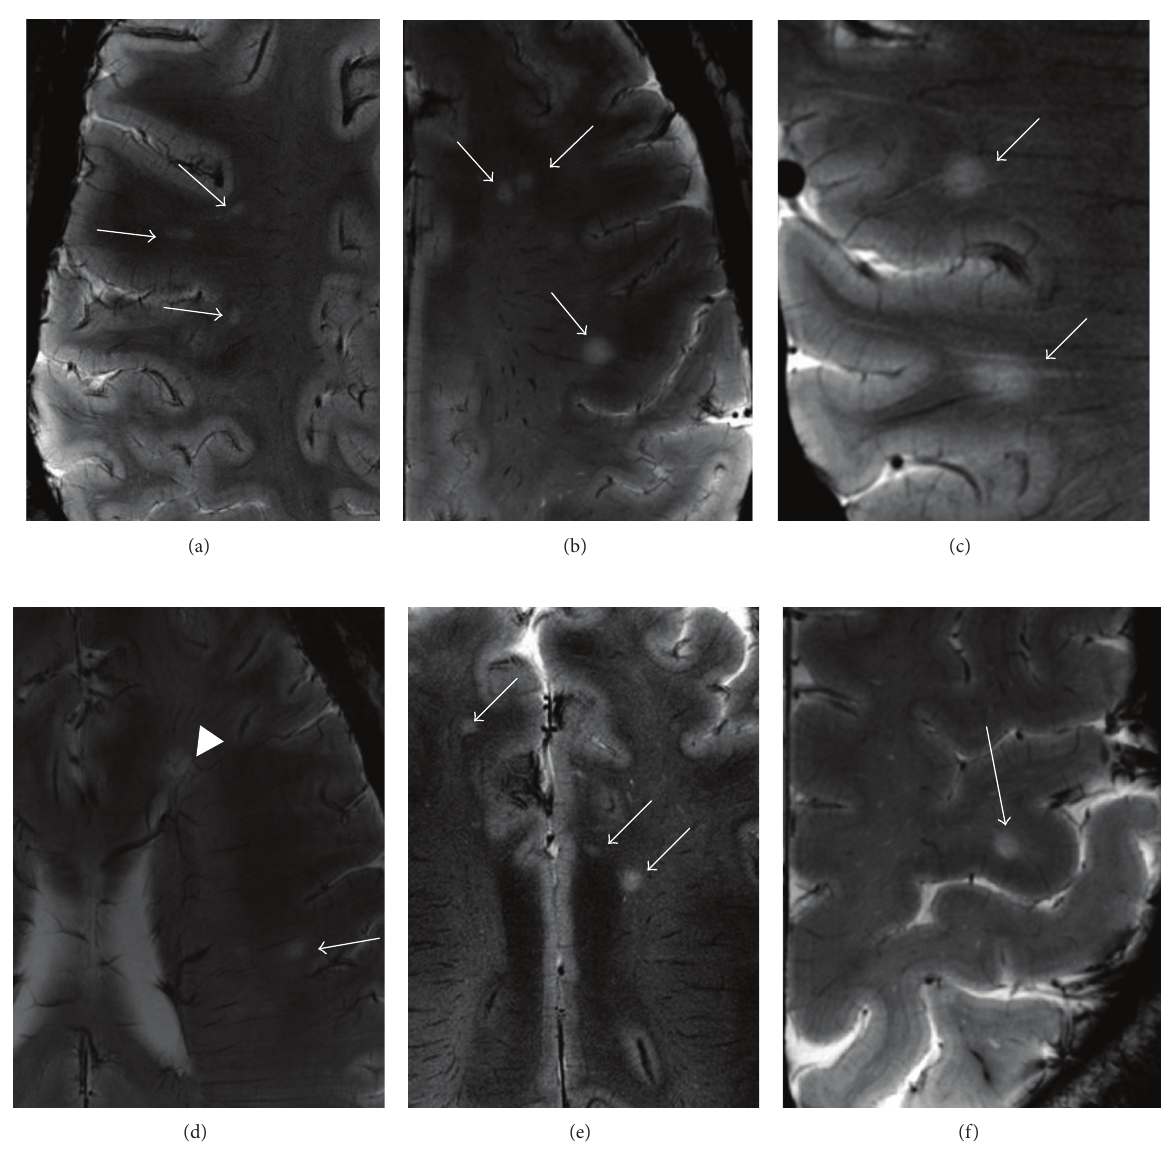
F 1: Examples of typical lesions in NMOsd. Brain lesions on T2 -weighted GRE images with in-plane resolution of 0.2 ) (arrows in (a), (b), (c), (d), and (e)) are small, round-shaped, and located in ∗ subcortical regions without typical sign of central venule or perivenous migration as seen in MS lesions. Only a few lesions have visible central veins (arrowhead in (d); this particular lesion was seen in enhance with gadolinium on a conventional brain MRI study performed % three years previously). Only 3 lesions are juxtacortical (long arrow in %